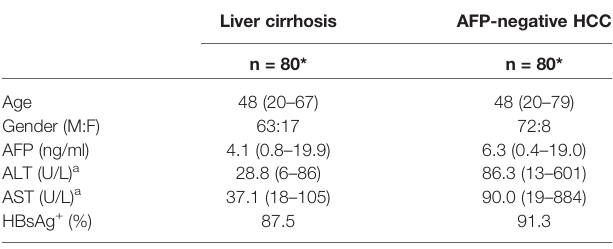
TABLE 1 | General information and clinical characteristics of the